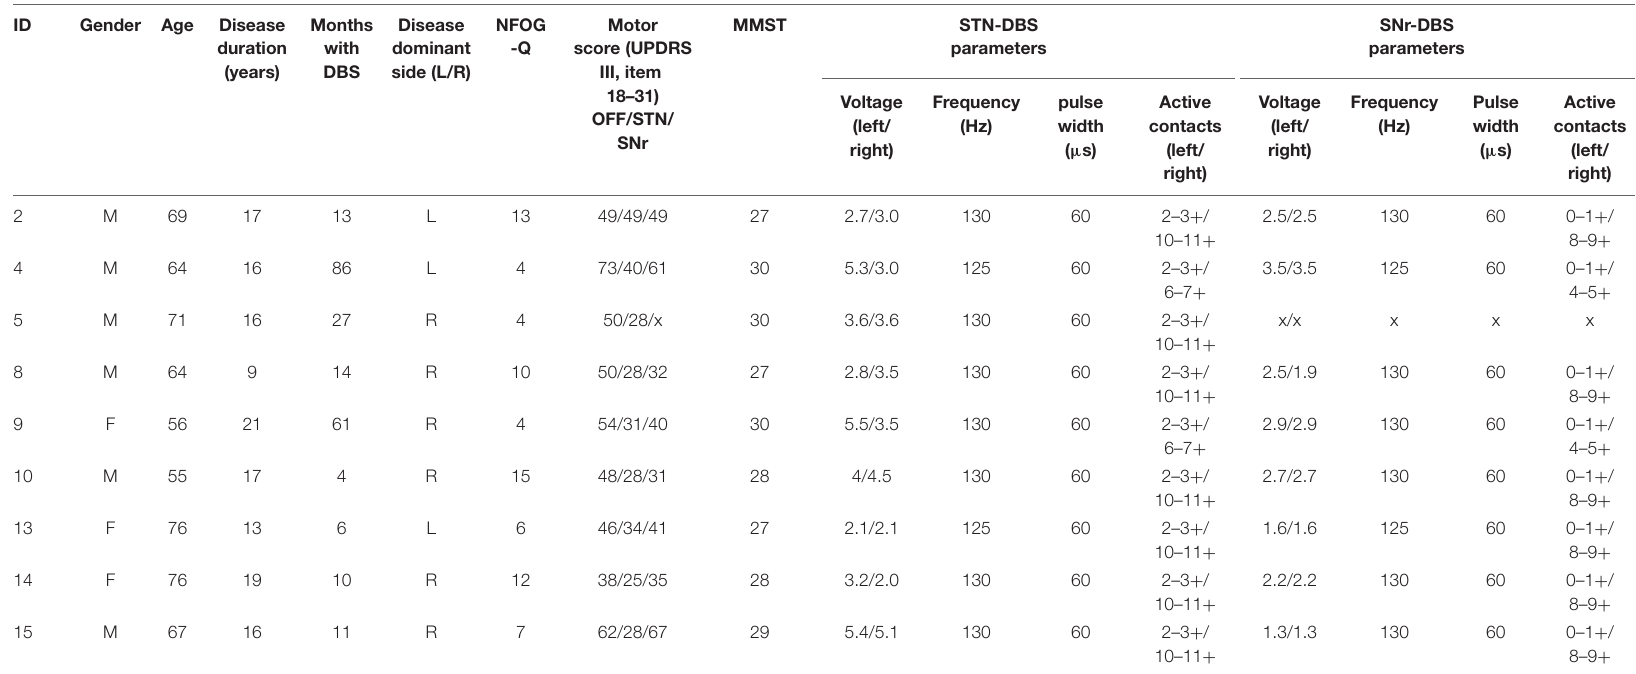
TABLE 1 | Patient characteristics of the final analysis cohort; NFOG-Q, New Freezing of Gait Questionnaire (Seuthe et al., 2021); STN-DBS, deep brain stimulation of the subthalamic nucleus; SNr-DBS, deep brain stimulation of the substantia nigra pars